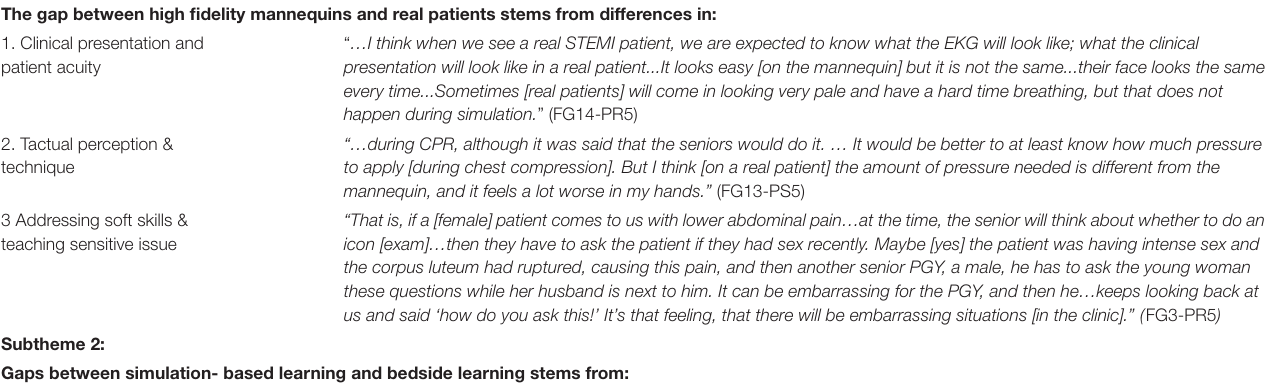
TABLE 4 | Representative quotes of theme 3—Limitations of EM internship rotation curriculum and pre-course simulation. Subtheme